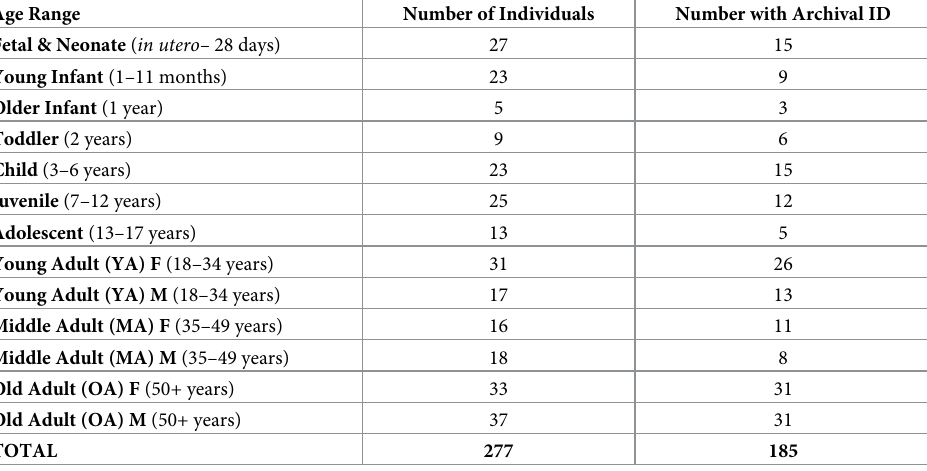
Table 1. Number of analyzed individuals from Beemster per age